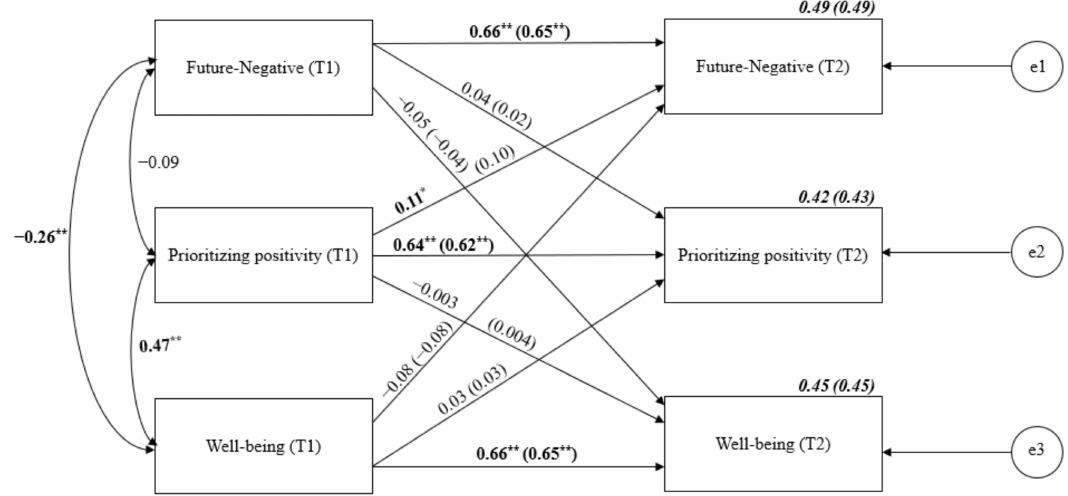
Figure 6. Cross-lagged panel analysis of Future-Negative TP, prioritizing positivity and well-being. Notes: Path entries are standardized estimates. T1 and T2 indicate the time when data were collected (Time 1 or Time 2, respectively). Estimates for the corresponding model with age and gender controlled are given in brackets. e1–e3 refers to the residual error or error variance that causes response variation in observed variables. * p < 0.05; ** p <